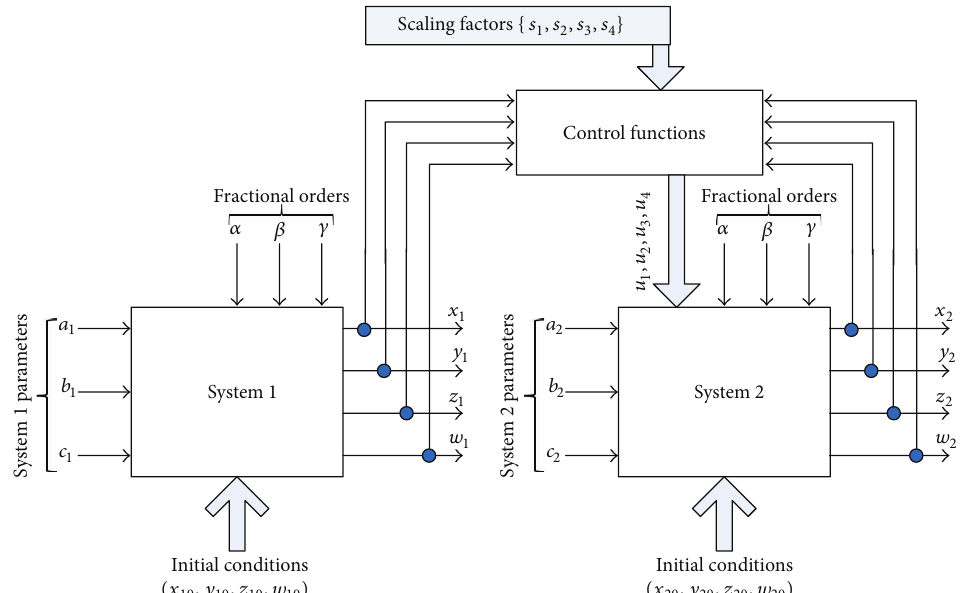
Figure 2: The proposed block diagram.